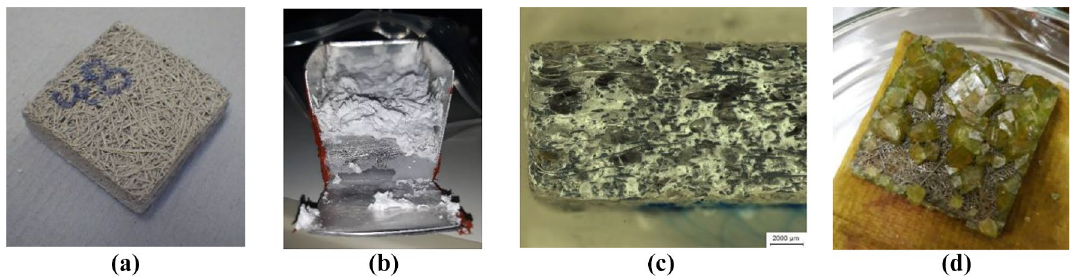
Figure 12. Aluminium fibres coated with ( a ) Al 2 (SO 4 ) 3 , ( b ) and ( c ) MgSO 4 and ( d ) SS-316L with FeCl 2 .